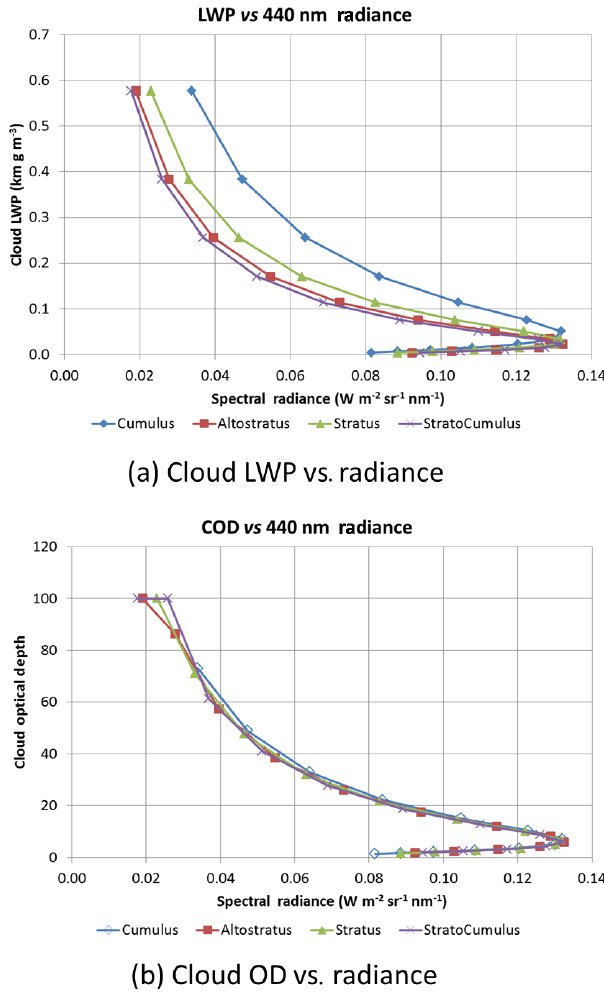
Figure 5. Relationship between spectral radiance at 440nm wave- length and (a) liquid water path (LWP) and (b) cloud optical depth, for four different cloud types: effective radii of 12.0 (cumulus), 7.2 (altostratus), 8.3 (stratus), and 6.7µm (stratocumulus).